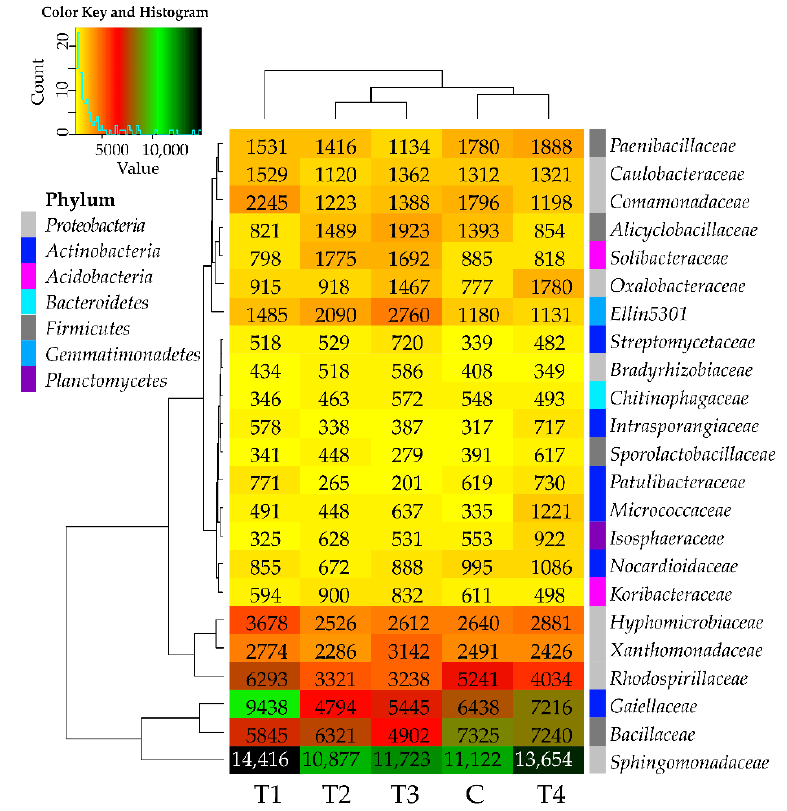
Figure 3. Relative abundance of the predominating bacterial families in the soils tested with the difference between ratios at ≥ 1%. Tebuconazole doses in mg kg − 1 : C—control soil, T1—0.01 mg, T2—0.1 mg, T3—0.5 mg, T4—1.0 mg.